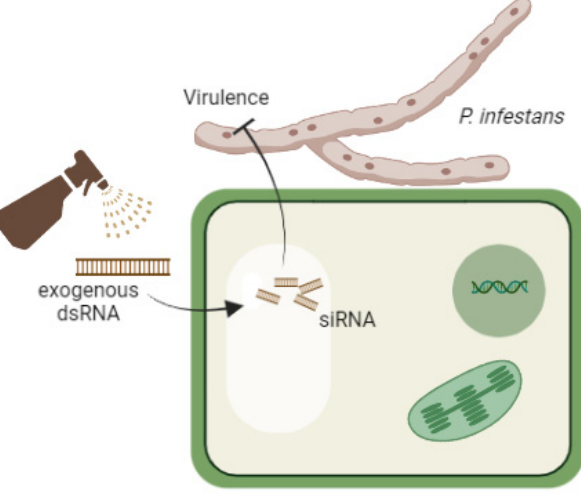
Figure 3. The scheme of SIGS action against P. infestans.